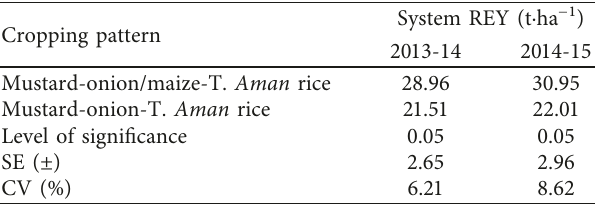
Table 4: System productivity (REY ∗ ) of component crops in different cropping